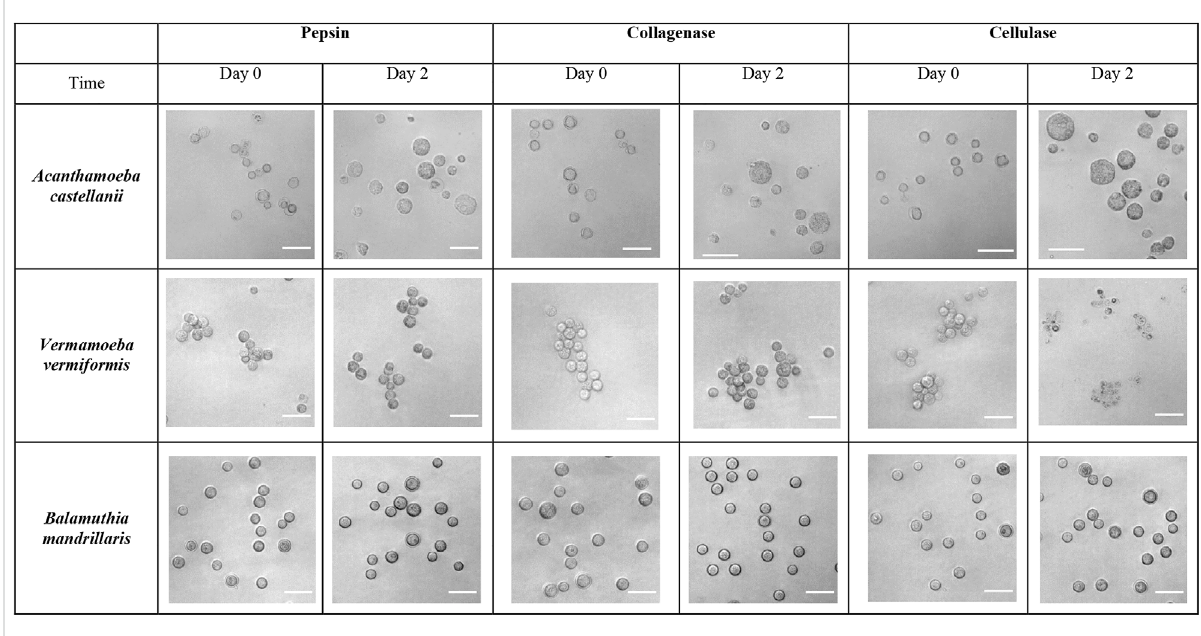
FIGURE 5 Effect of cellulase, collagenase and pepsin on the excystment of Acanthamoeba castellanii , Vermamoeba vermiformis , and Balamuthia mandrillaris .Phasecontrastobservationof A.castellanii , V.vermiformis ,and B.mandrillaris before(Day0)andaftertreatmentoftheircystsfor2 days at 30 ° C by 100 U/mL pepsin, 50 U/mL collagenase, or 7.5 U/mL cellulase. Scales bars = 20